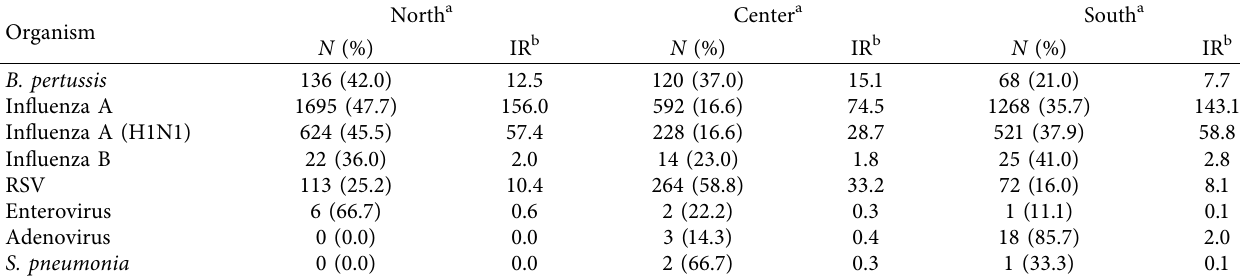
Table 5: Frequency and incidence rates of confirmed respiratory tract infection-related hospitalization stratified by region.